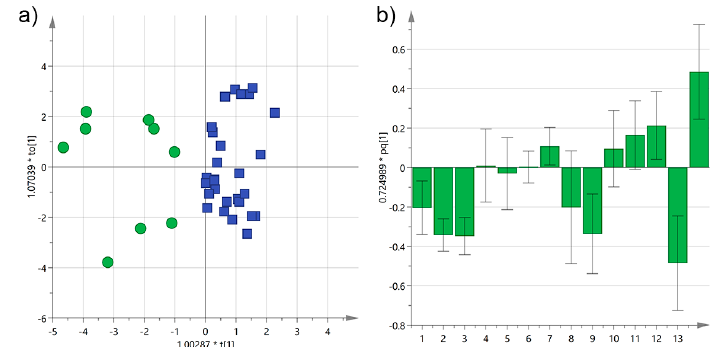
Figure 13. ( a ) OPLS-DA score plot for EVOO samples from Salento categorized by PDO certification (green circles = non-PDO; blue squares = PDO); ( b ) OPLS-DA loadings column plot for the first predictive component of the model (variables: 1 = total biophenols; 2 = hydroxytyrosol; 3 = tyrosol; 4 = 3,4-DHPEA-EDA; 5 = 3,4-DHPEA-EA; 6 = lignans; 7 = luteolin; 8 = p -HPEA-EDA; 9 = p -HPEA-EA; 10 = 3,4-DHPEA-EA in the mixed aldehydic and hydroxylic form; 11 = p -HPEA-EA in the mixed aldehydic and hydroxylic form; 12 = α -tocopherol; 13 = non-PDO; 14 =